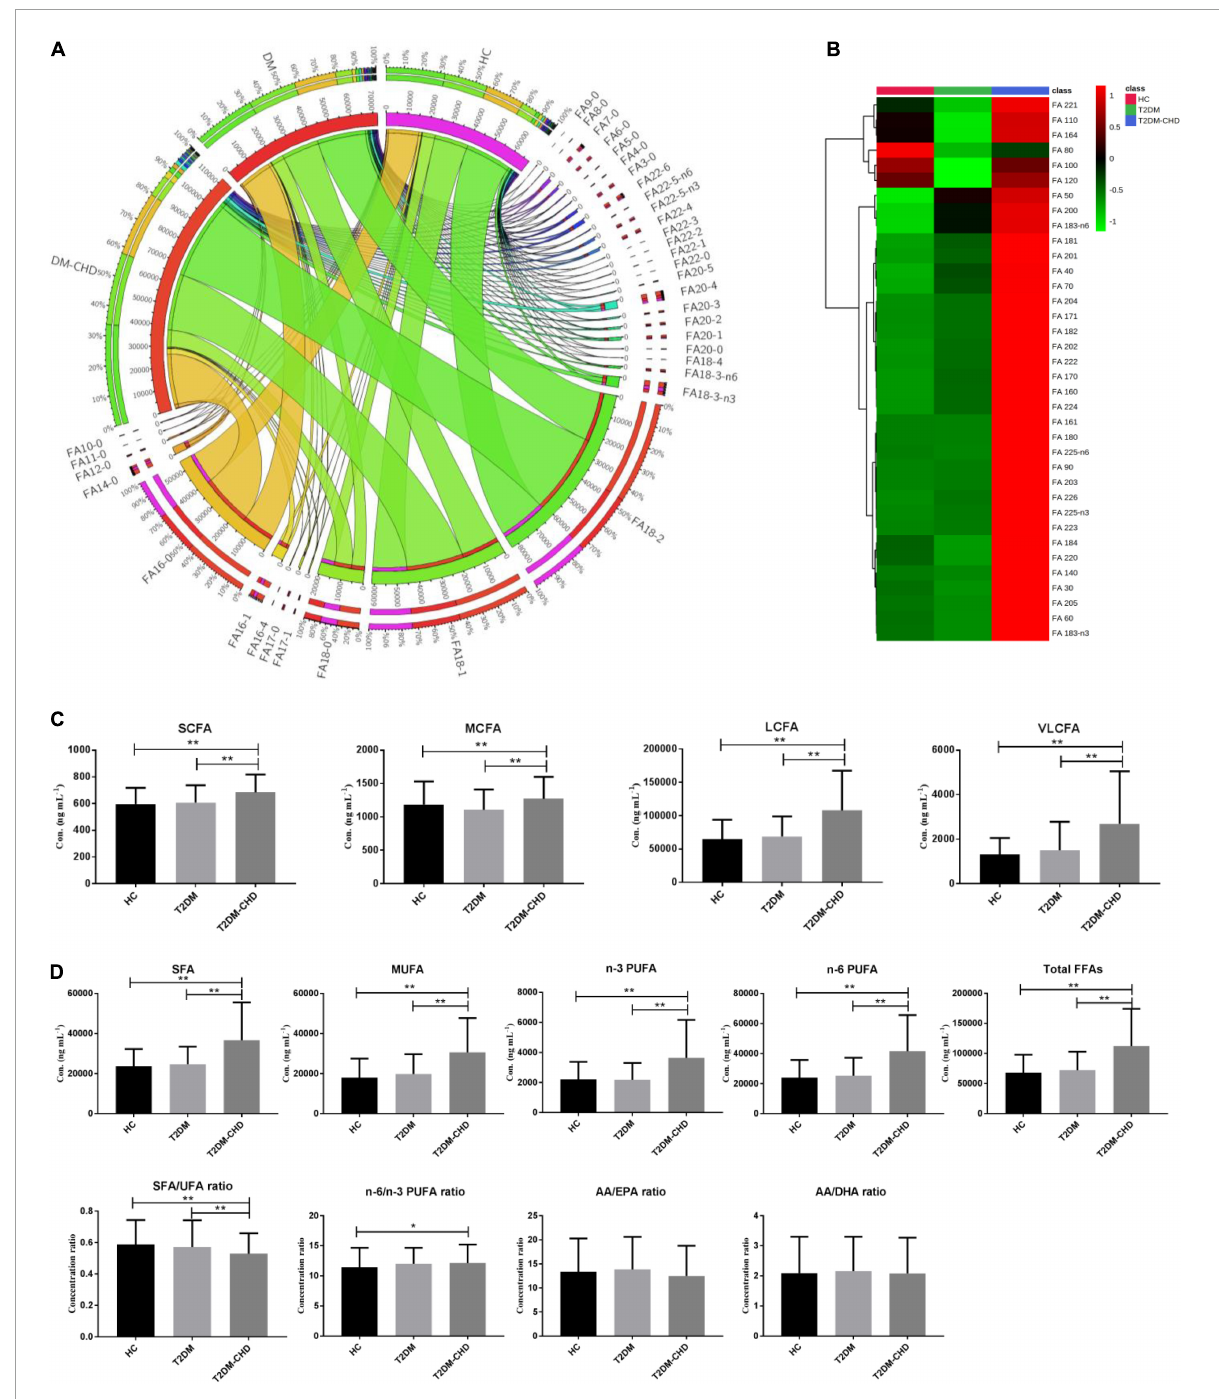
FIGURE2 (A) Circos plot exhibited the distribution of FFAs in each groups. (B) Heatmap showing the average FFA concentrations in each group. (C) Histogram of FFAs with different carbon chain lengths. (D) Histogram of FFAs with different unsaturation. The ratios of different FFAs were also compared. * P < 0.05; ** P < 0.01. P values were calculated by hypothesis testing. Data distribution was assessed by the Shapiro–Wilk test. Bilateral student’s t -test was used for normally distributed data. While the Mann–Whitney U test was used for non-parametric